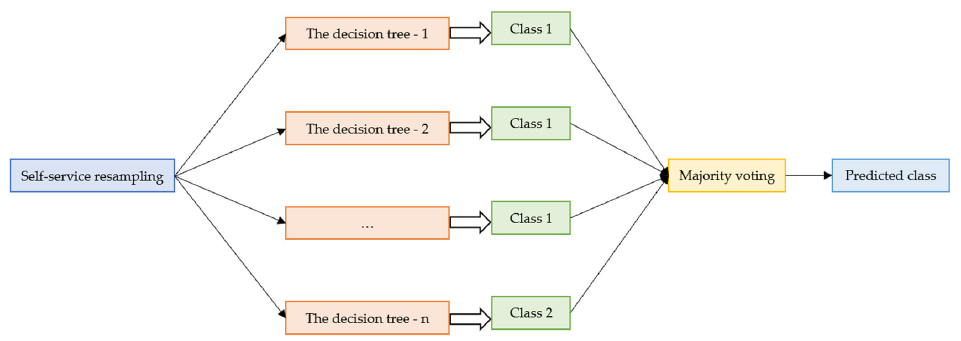
Figure 4. Flow chart of random forests.